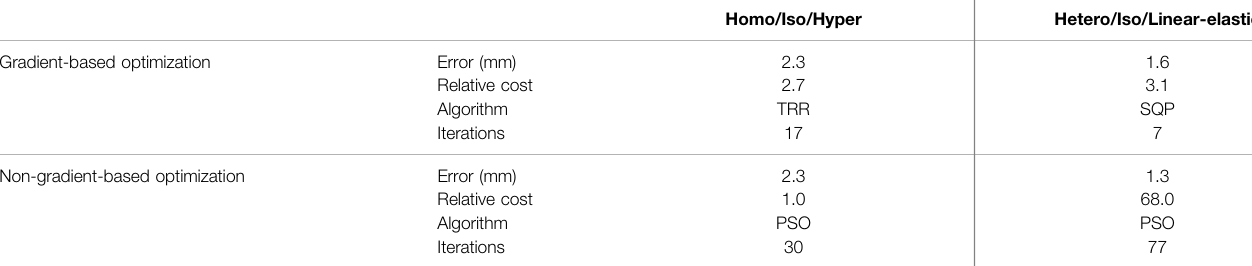
TABLE 3 | General IFEA settings and